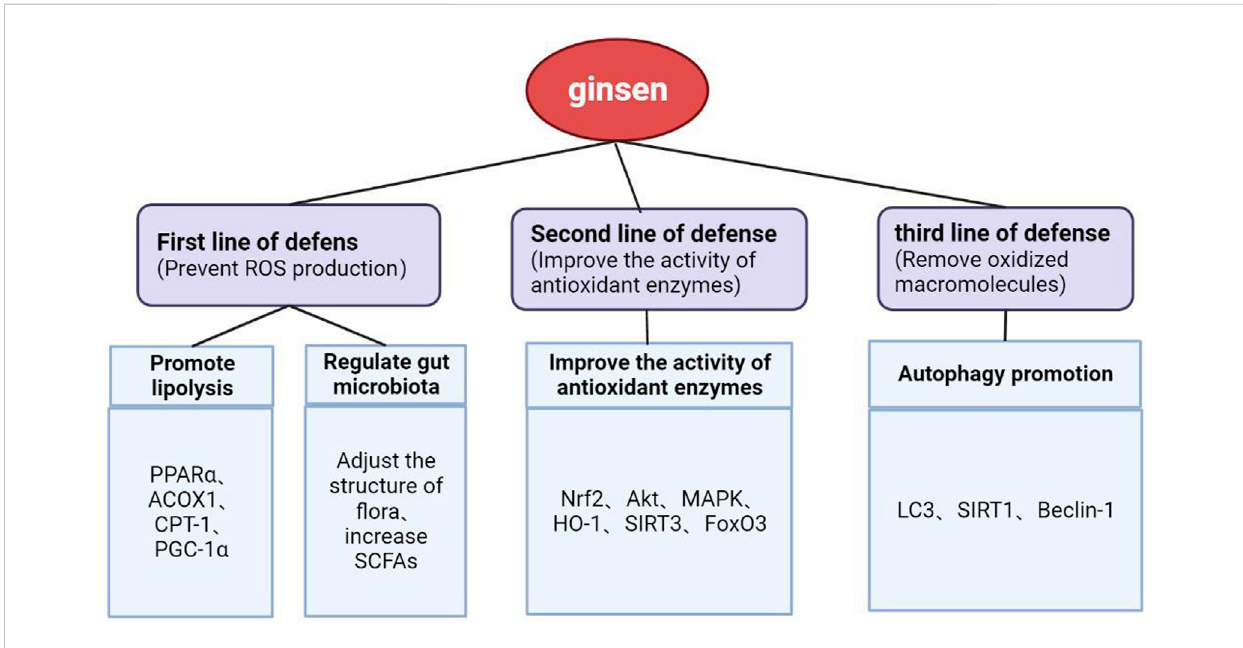
FIGURE 4 Ginseng improves lipid metabolism in hyperlipidemia by regulating oxidative